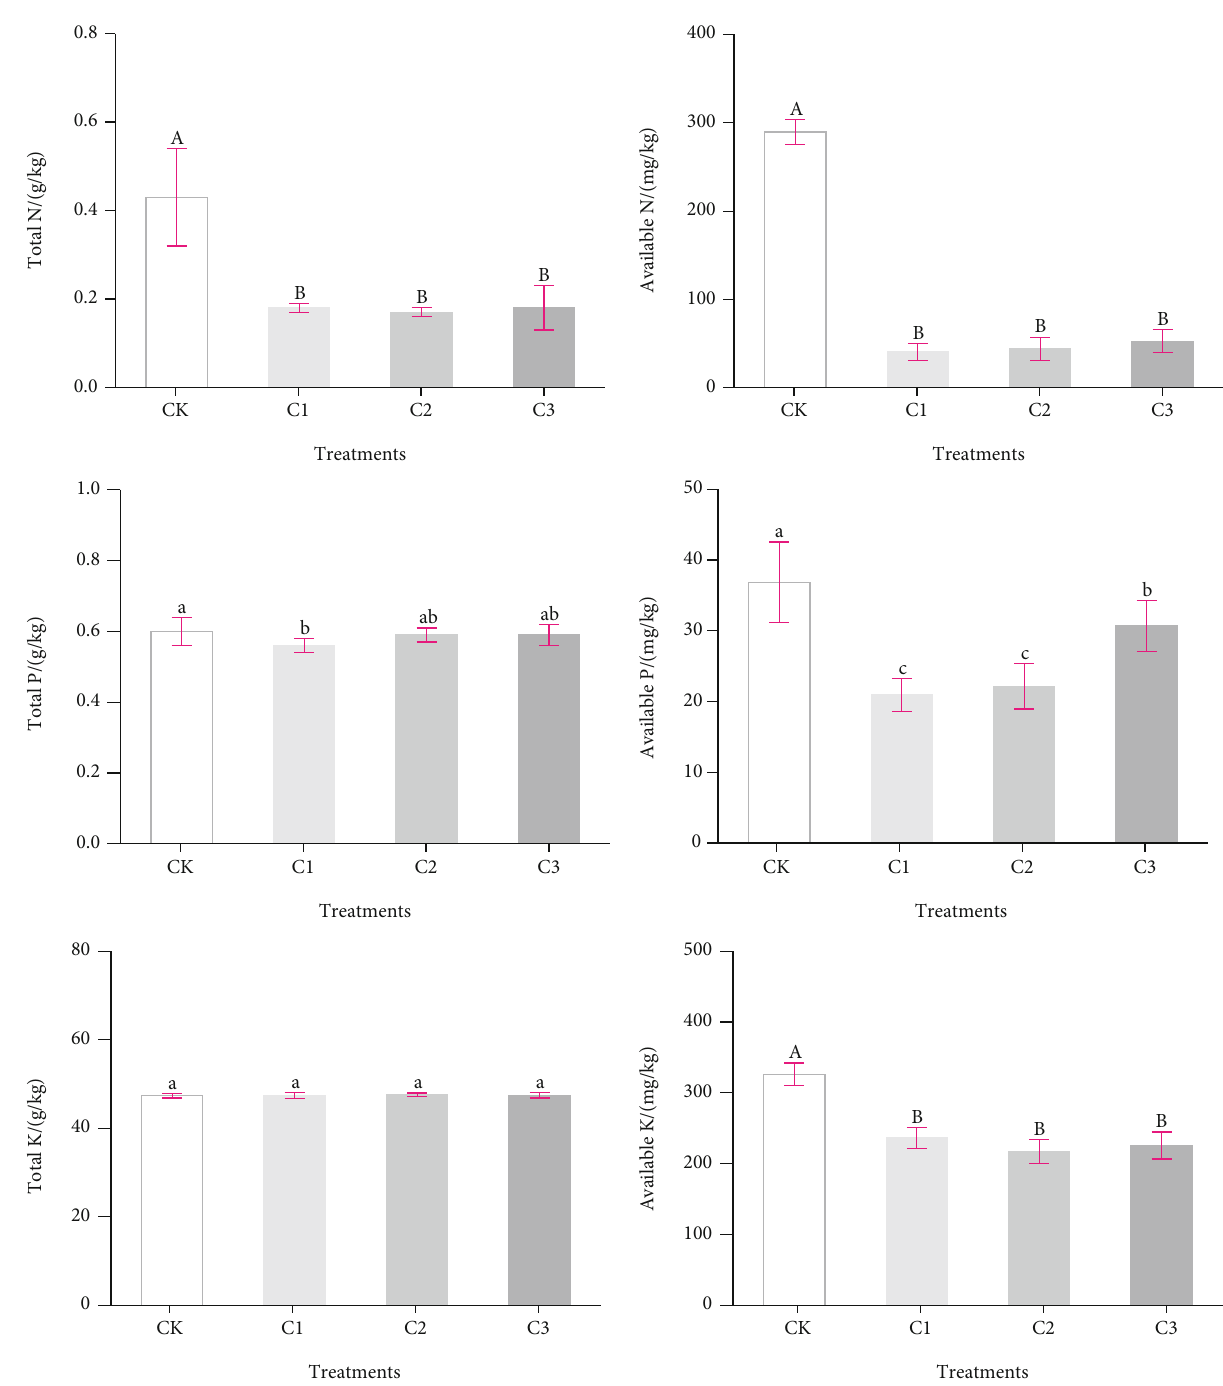
Figure 3: E ff ect of lime combined with fertilizer on soil fertility of rare earth mine tailings. CK: fertilizer (0.20 gN, 0.30g P K O per kg of tailings); C1: fertilizer + 10g/kg lime; C2: fertilizer + 25 g/kg lime, and C3: fertilizer + 50 g/kg 2